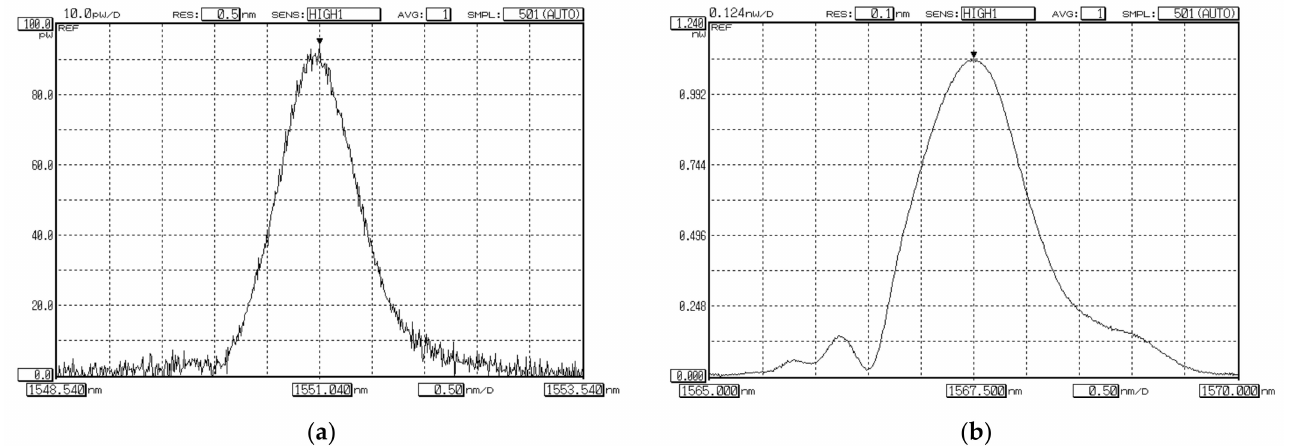
Figure 9. Spectral responses of FBG, excited by laser-source (CE LD, λ = 1550 nm): ( a ) FBG on SMF; ( b ) FBG on FMF